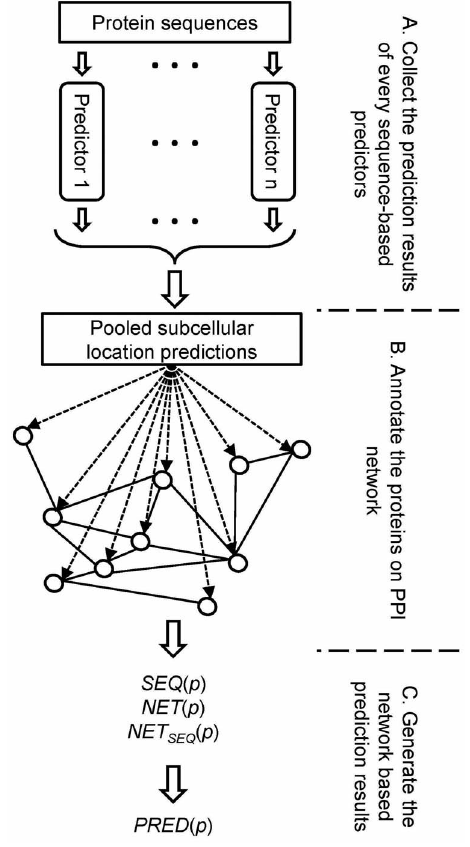
Figure 3. The information flow chart of the whole framework. The input of the framework is only the protein sequences. There are three phases in the whole process. (A) In the first phase, several existing sequence-based predictors give prediction results using only protein sequences. In the current study, these sequence-based predictors include the Y-Loc predictor and the Hum-mPLoc 2.0 predictor. The number n is 2. (B) In the second phase, the prediction results of the first phase were collected and then annotated on a protein-protein interaction network. (C) In the third phase, the annotated protein- protein interaction network was analyzed and the network-based prediction results were generated.